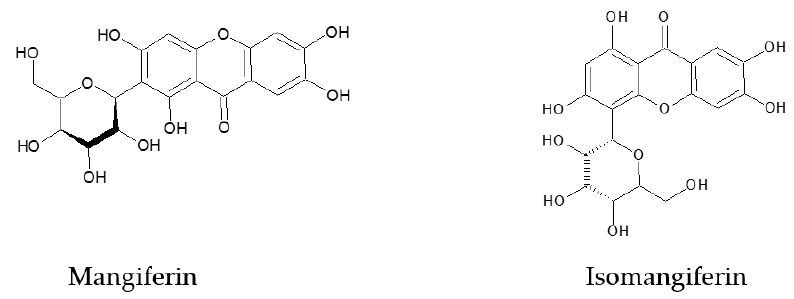
Figure 2. Chemical structures of mangiferin and isomangiferin isolated from mango